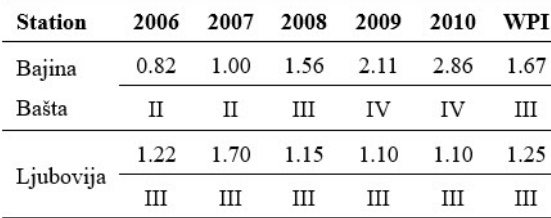
Table 1. WPI value in analyzed